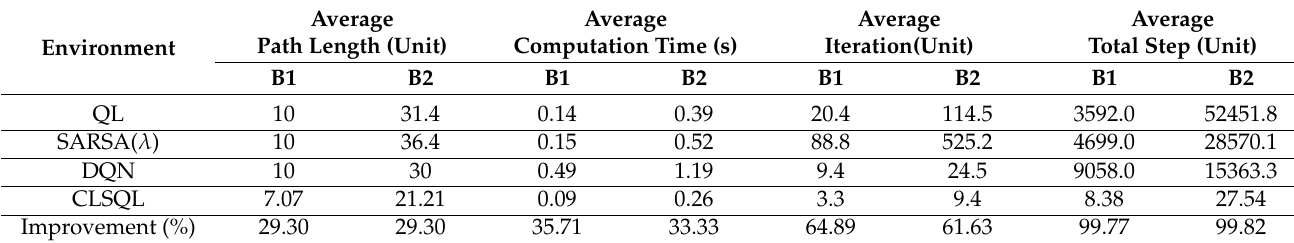
Figure 11. The optimal path of B2. Table 3. Average Performance Comparison of Obstacle-free Maps.